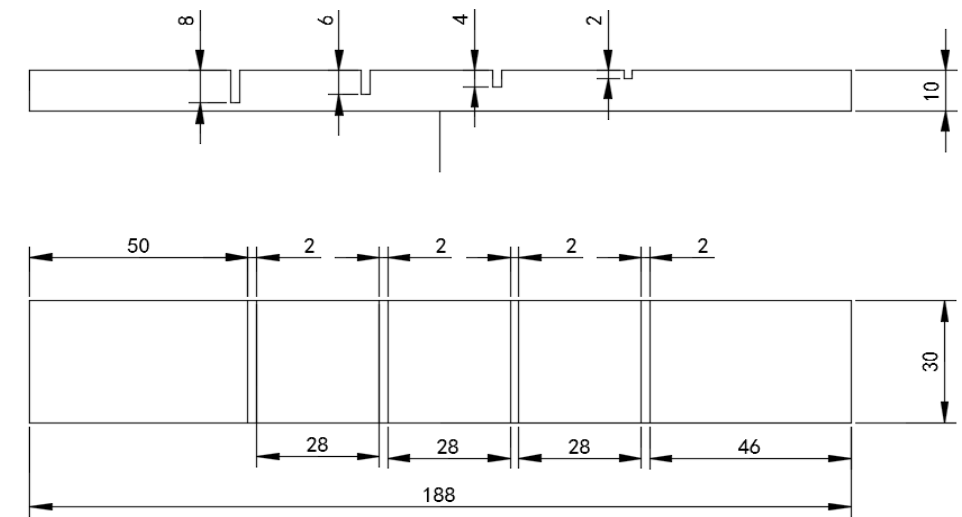
Figure 3. The geometric parameters of the PEC testing sample.